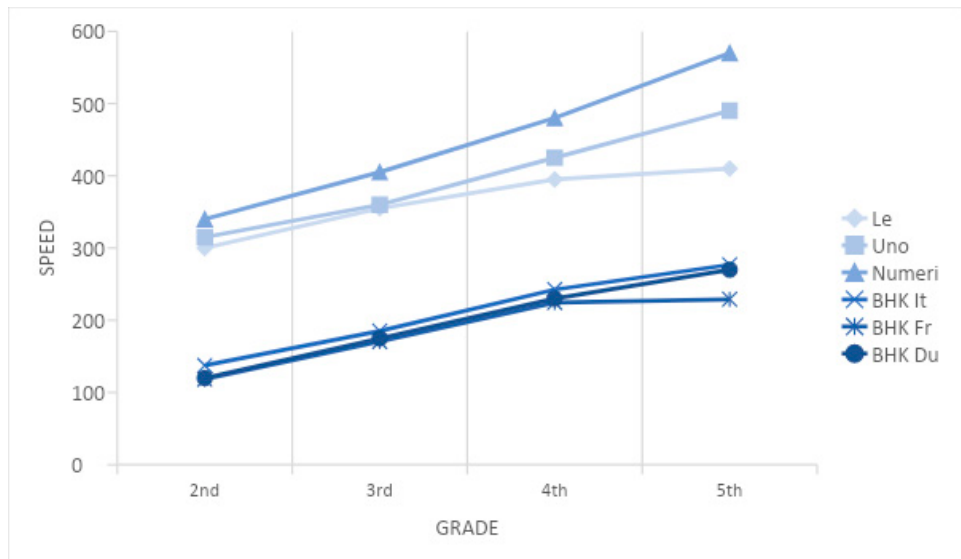
Figure 1. Comparison among the speed in three different versions of BHK (Italian, French, and 296 Dutch) and the three subtests of the BVSCO (“le”, “uno”, and “numeri”) for school level. 297 These studies described a continuous and somehow linear increase in the writing 298 speed through the second to the fifth grade. The comparison with second- and third-grade 299 Dutch children [24] reveals a similar speed for the second and third graders (with a higher 300 SD in the Dutch sample). Other instruments that measure the writing speed that are in 301 use in Italy, such as the BVSCO, use a self-dictation of disyllables, single words, and num- 302 bers. Higher speeds shown in this test are probably in relation to a simpler task. 303 The present study confirms that sex influences total BHK quality score (i.e., legibility) 304 and that school level within primary school influences handwriting speed (i.e., fluency).